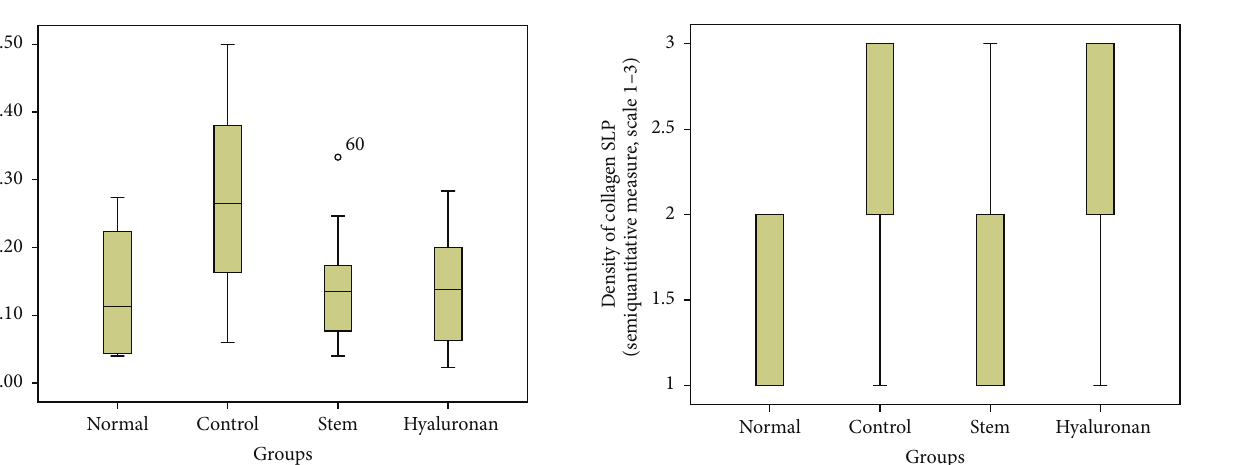
Figure 14: Density of collagen in the superficial lamina propria (SLP). Normal = normal/control group, control = scarred/control group, stem = stem cell group, and hyaluronan = hyaluronan